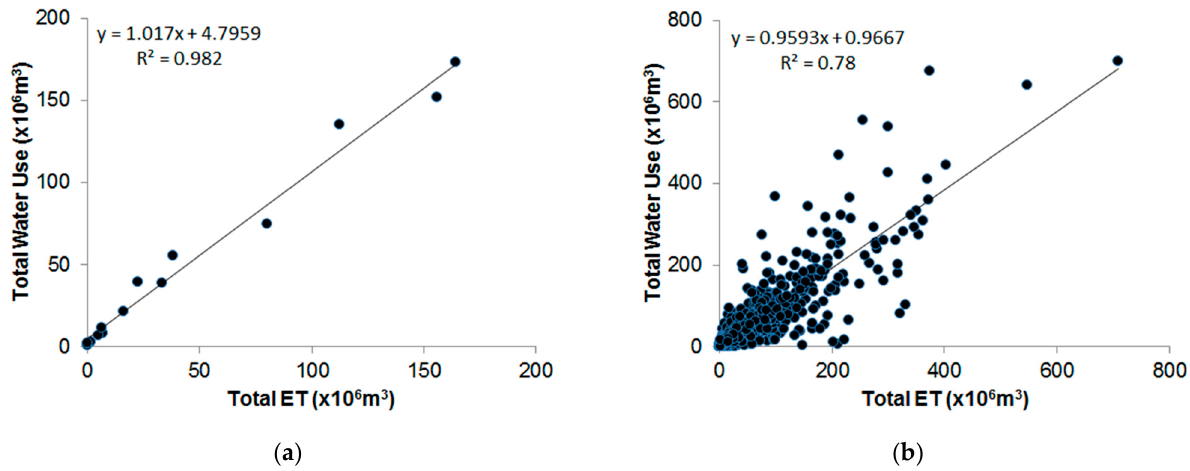
Figure 5. Comparison between total annual ET and total water use. ( a ) Irrigation district level; ( b ) farm unit level.